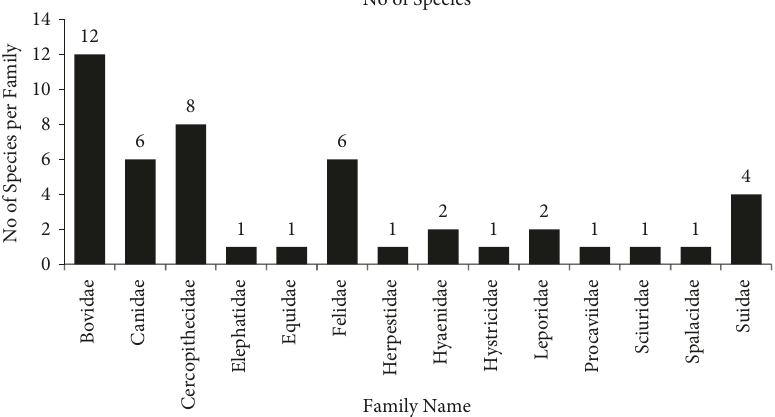
Figure 3: Distribution of taxonomy in reviewed studies.